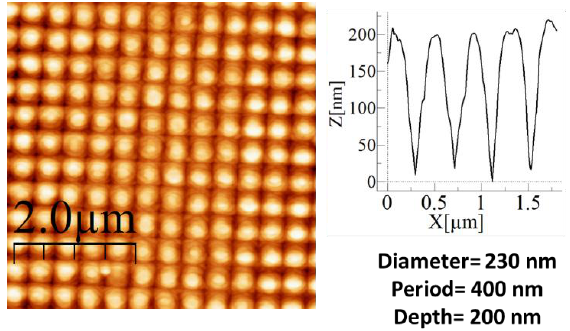
Figure 6. AFM image of ordered 2D nanostructures on glass.